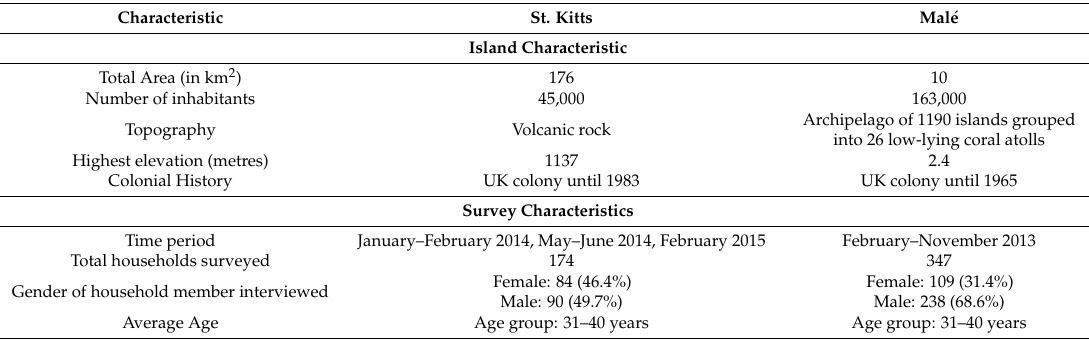
Table 2. Island and survey